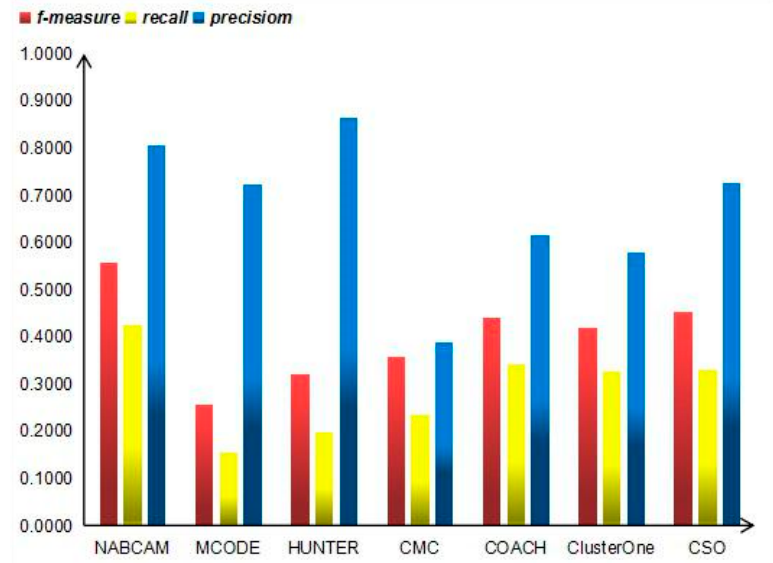
Figure 8. Precision , recall and f-measure values of various algorithms on the Krogan dataset.